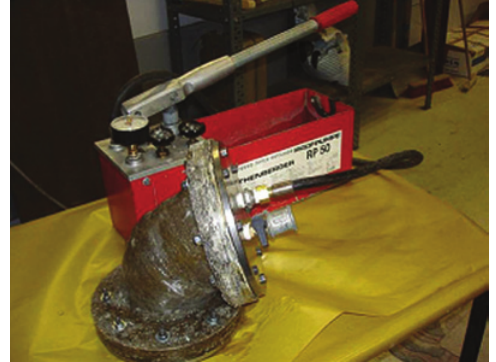
Figure 16: Fittings build with hybrid glass/hemp lay-up [40].